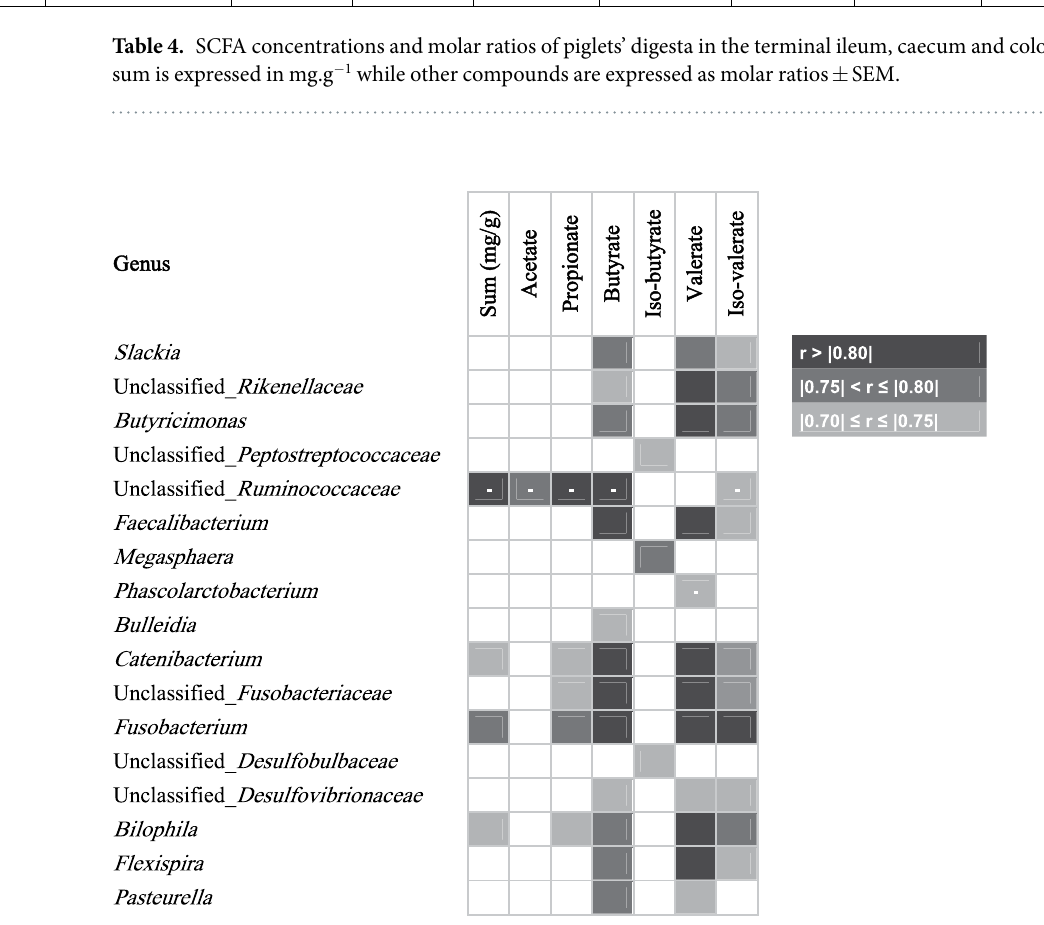
Table 5. Pearson’s correlations between SCFA molar ratios and genera of the microbial community in the colon of piglets from sows fed a control and a wheat bran-enriched diet (N = 14). Only the results with a p-value < 0.05 and r > 0.70 were included in this table. Negative correlations are expressed in the table with the symbol